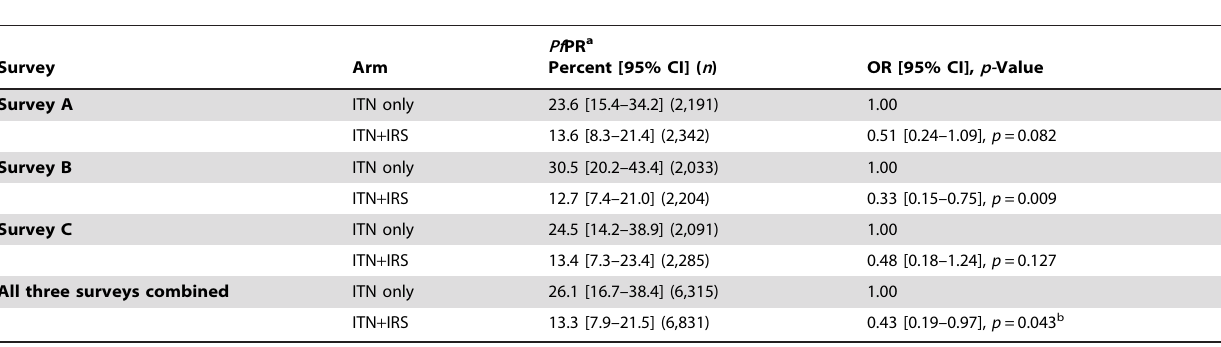
Table 4. Pf PR in children 0.5–14 y old in the ITN only and ITN + IRS arms (intention to treat) in survey A, B, and C, Muleba District, Tanzania,